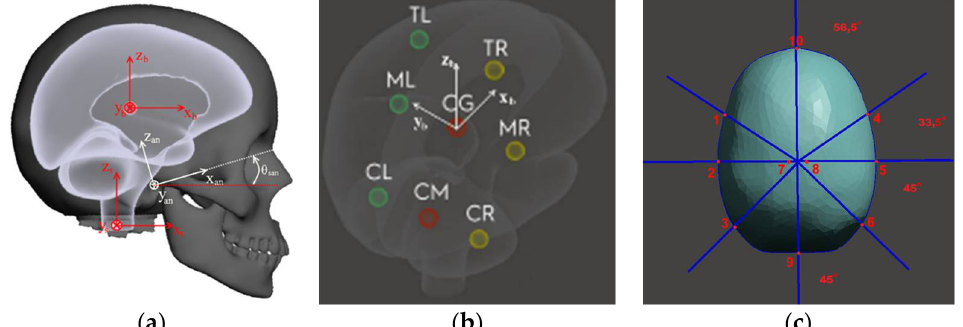
Figure 2. ( a ) Head and brain systems of reference; ( b ) location of 9 sensors in the brain; ( c ) disposition of pressure sensors in the